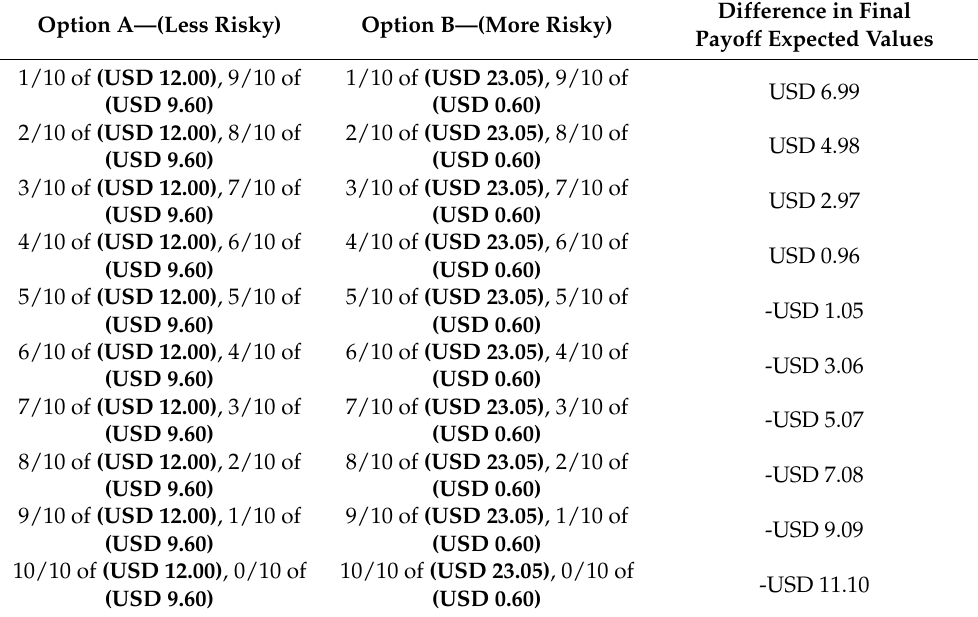
Table A3. Rationally equivalent payoff-based lotteries along with their corresponding final payoff expected